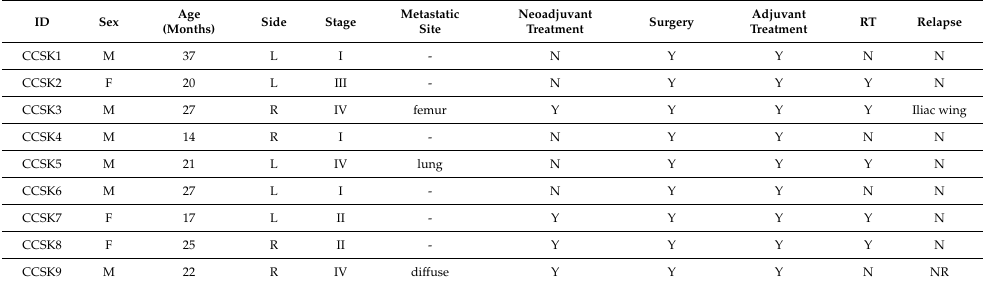
Table 1. Patients’ characteristics. L, left; R, right; RT, radiotherapy; NR, no remission. ID Sex Age (Months) Side Stage Metastatic Site Neoadjuvant Treatment Surgery Adjuvant Treatment